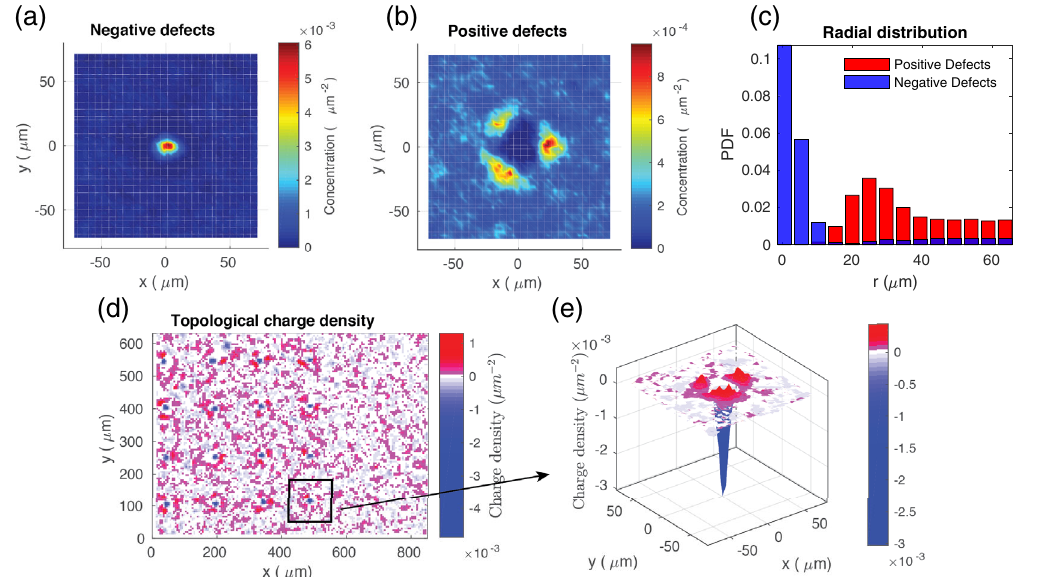
Fig. 2 Defect and topological charge distributions. Heat map of the average concentration of negative ( a ) and positive ( b ) defects. Color bars represent the defect concentrations. The center of the pillar is located at ( X = 0, Y = 0). c Probability distribution function (PDF) of defect concentrations vs distance from the pillars r . The half-distance between pillars is 73 μ m. d Topological charge density inside the pillar lattice ( X < 500 μ m) and in unconstrained area ( X > 500 μ m). Average values are C in = (1.9 ± 0.7) × 10 − 4 μ m − 2 and C out = (1.5 ± 0.5) × 10 − 4 μ m − 2 respectively. Color bars represent the charge densities. e Average topological charge density around a pillar.